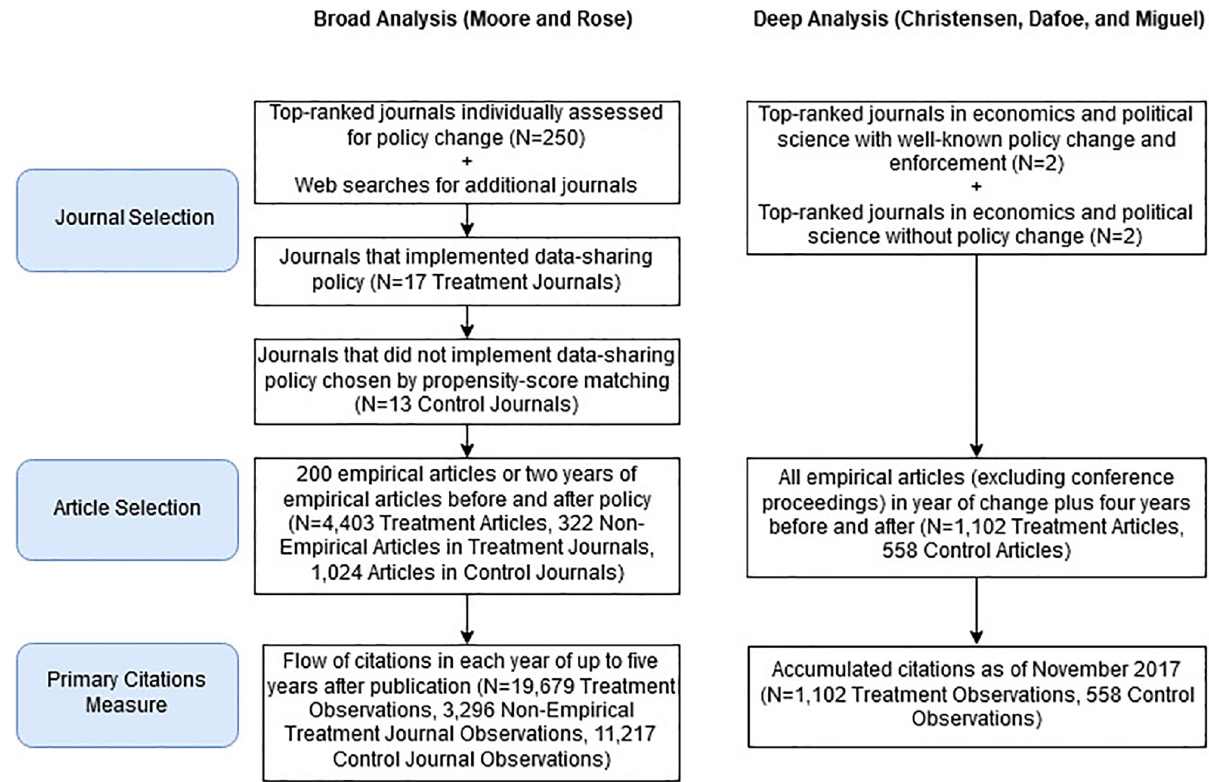
Fig 1. Flow diagram of sample selection. Separately our two teams selected journals, then used all empirical articles in those journals as treated observations.